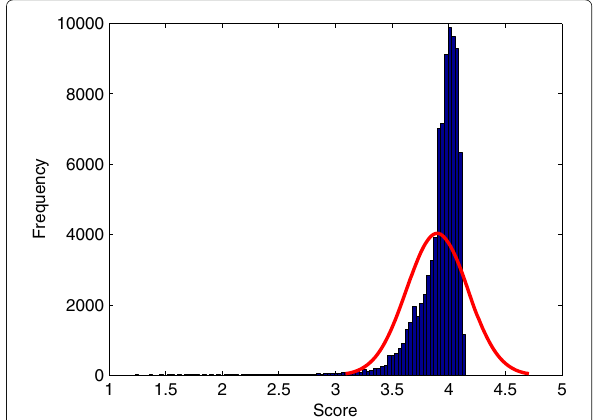
Fig. 1 vMOS histogram of frequency